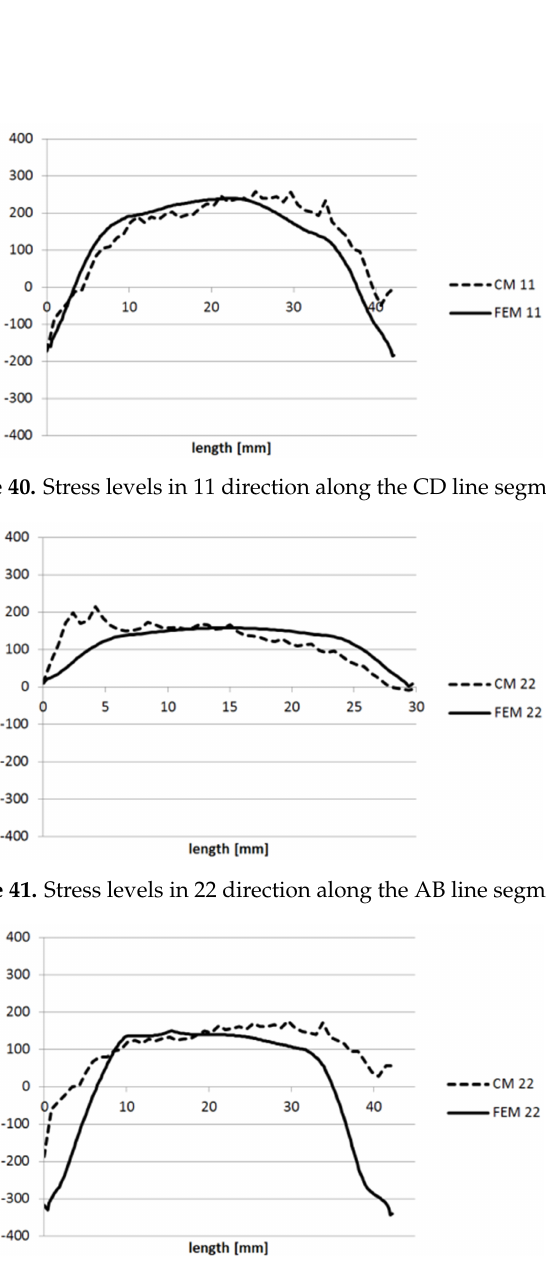
Figure 42. Stress levels in 22 direction along the CD line segment.